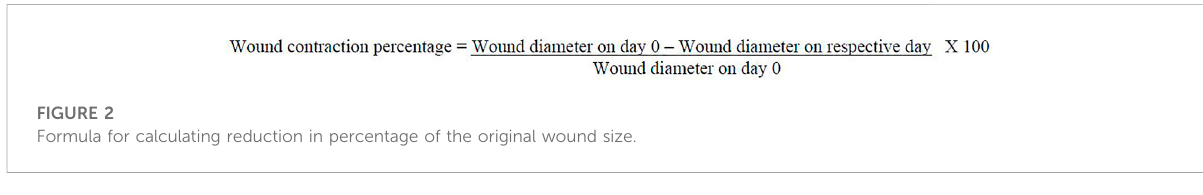
FIGURE 2 Formula for calculating reduction in percentage of the original wound